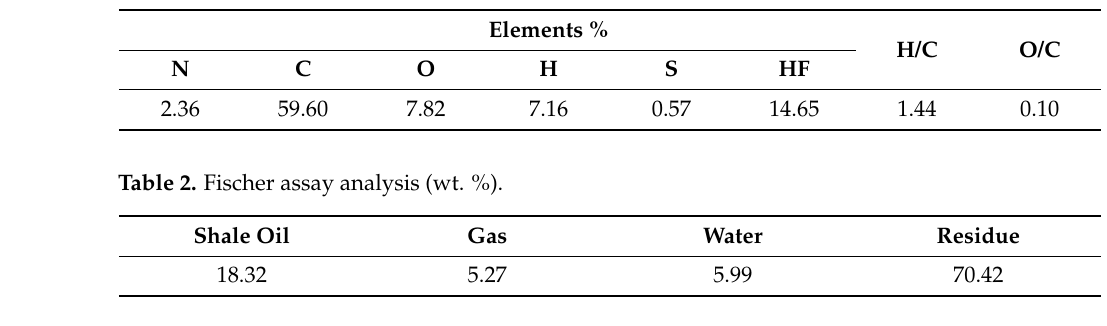
Table 1. Organic elements of Huadian oil shale.